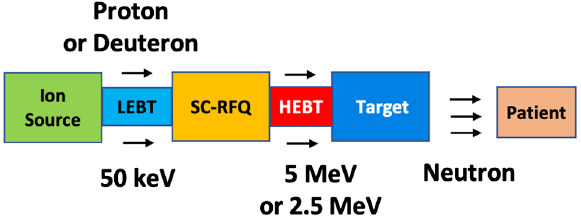
FIG. 4. Schematic of neutron source assumed in this